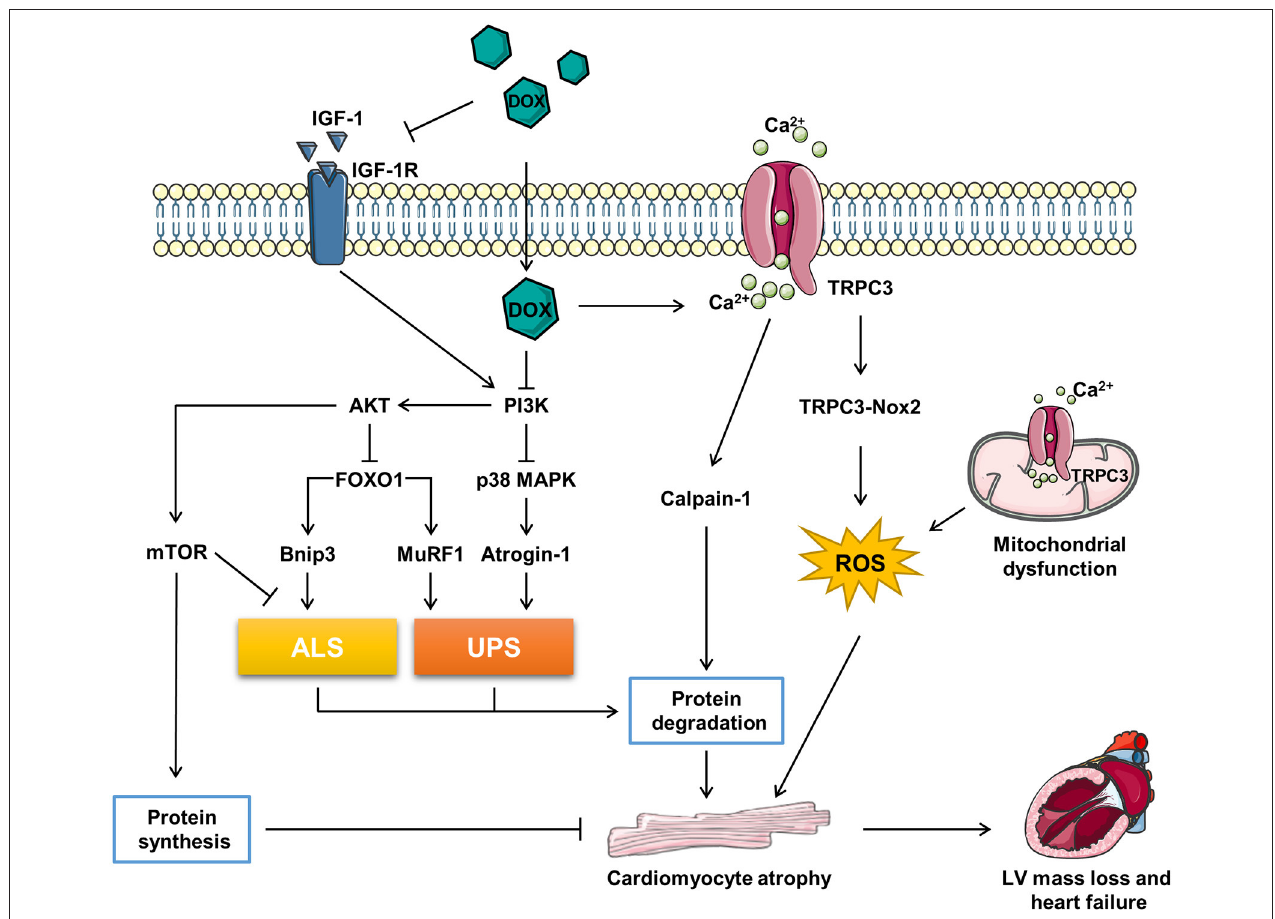
FIGURE 1 | The related molecular mechanism of doxorubicin (DOX)-induced cardiomyocyte atrophy (CMA). ALS, autophagy–lysosome systems; atrogin-1/MAFbx, muscle atrophy gene-1; Bnip3, Bcl-2 19-kDa interacting protein 3; DOX, doxorubicin; FOXO1, forkhead box O1; IGF-1, insulin-like growth factor; IGF-1R, IGF-1 receptor; MuRF1, muscle RING finger 1; mTOR, mammalian target of rapamycin; Nox2, NADPH oxidase 2; PI3K, phosphoinositide 3-kinase; p38 MAPK, p38 mitogen-activated protein kinase; TRPC3, transient receptor potential canonical 3; UPS, ubiquitin–proteasome